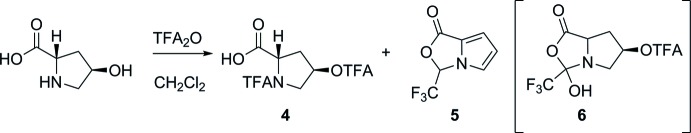
Reaction scheme for the synthesis of 5 along with the desired product 4.